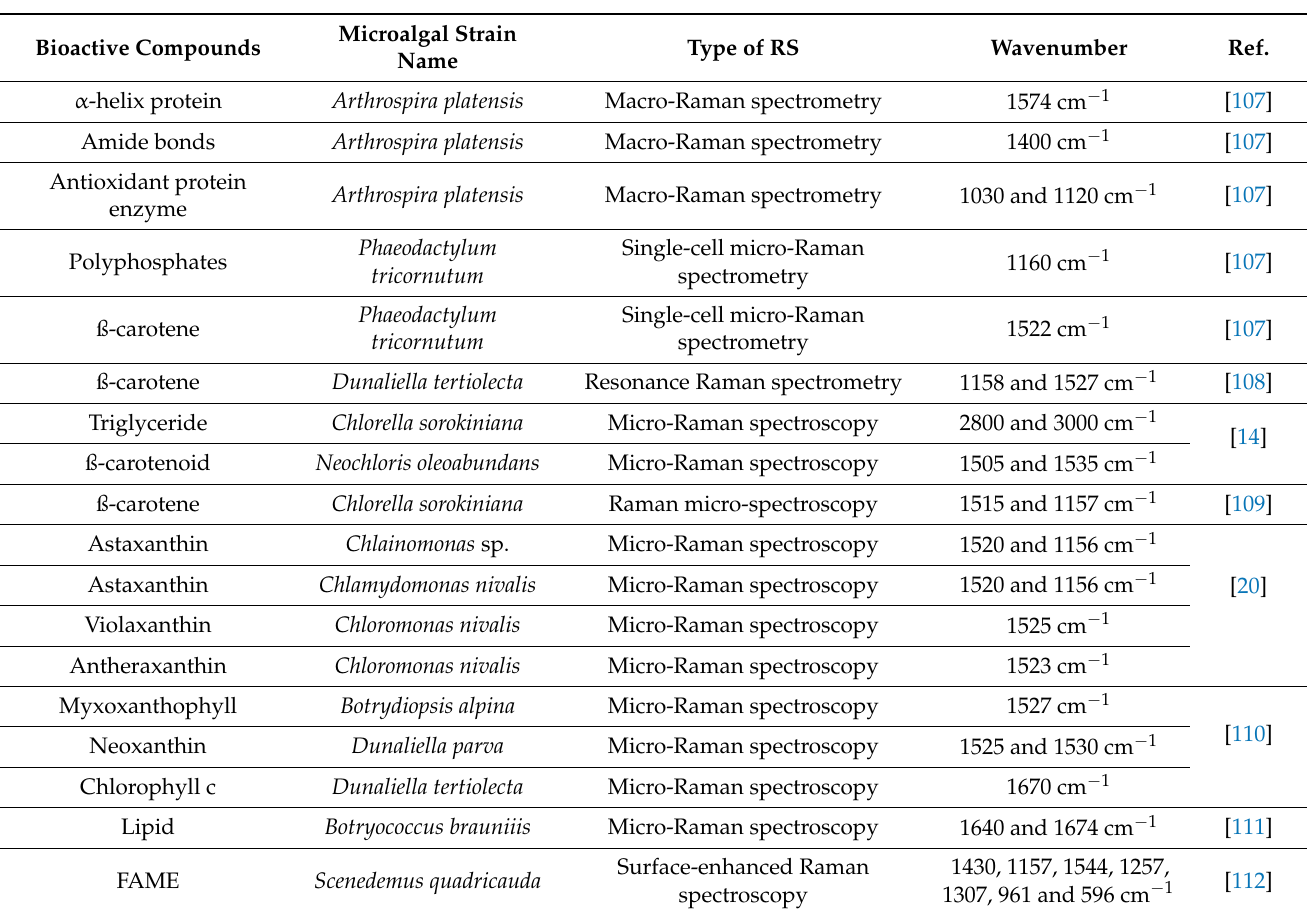
Table 3. Summary of the bands observed in the Raman spectra of microalgae and contributing bioactive